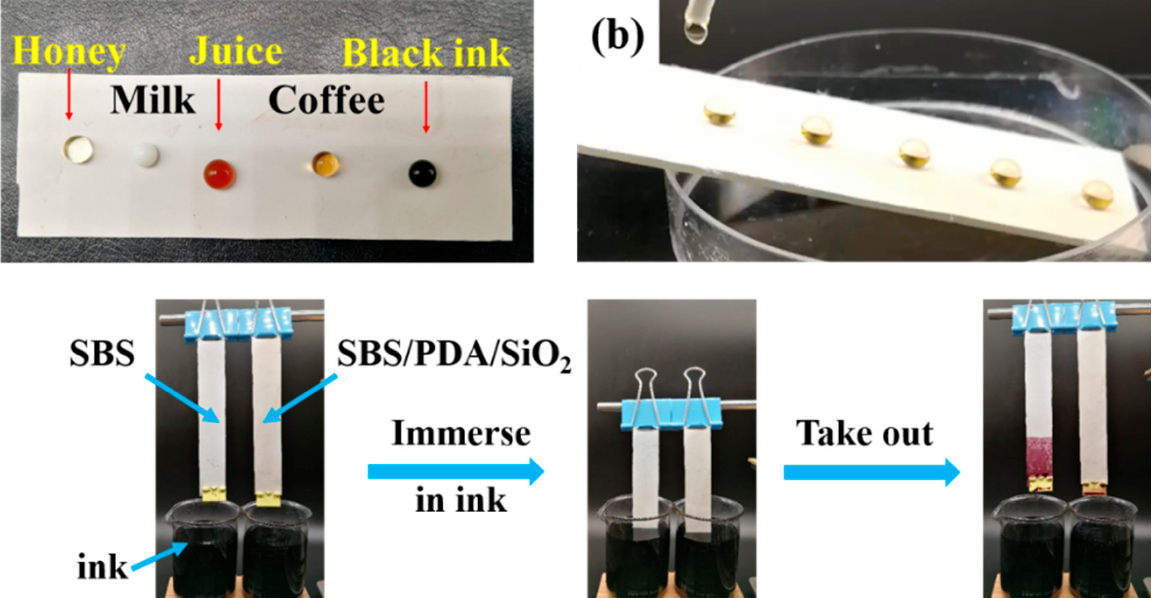
Figure 10. The SBS/PDA/SiO 2 fibrous membrane contaminated with CuSO 4 particles was washed cleanly with water. Two typical tests demonstrate that the SBS/PDA/SiO 2 fibrous membrane possesses excellent waterproof and breathable performances. As shown in Figure 11a and Movie S6, the SBS/PDA/SiO 2 fibrous membrane is placed on the sand core filter of a filter device. The above cup is filled with a 300 mL, 10.5 cm column of water. It can be found that there is no water permeating through the membrane under hydrostatic pressure, which can be ascribed to the super-hydrophobic surface and micron-pore structures of the fibrous membrane. Then, the air is pumped below bottle continuously. The air bubbles appear constantly in the above cup of water. The test reveals the excellent waterproof and breathable performance of the SBS/PDA/SiO 2 fibrous membrane. Another test is shown in Figure 11b, the SBS/PDA/SiO 2 fibrous membrane covers a beaker with 250 mL of 95 °C water. Then, the silica gel desiccants as moisture indicators are placed on the membrane surface and in a Petri dish at the same time. After 5 min, some of the silica gel desiccants